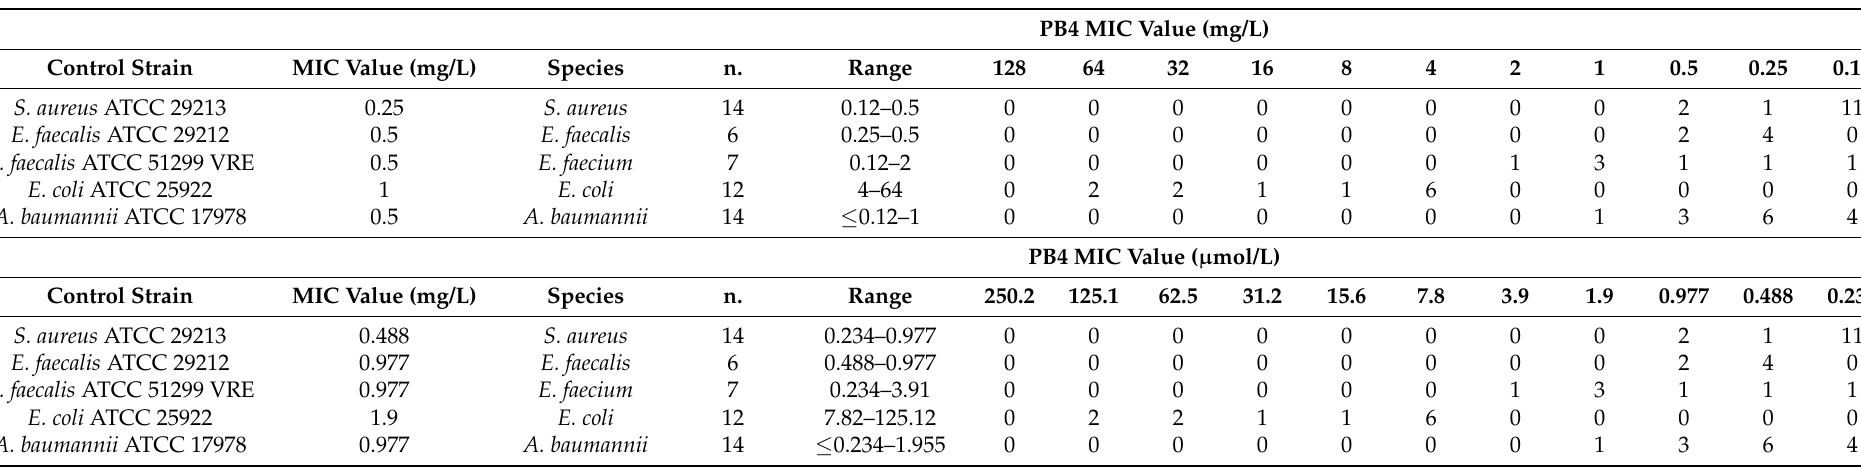
Table 5. The table reports the MIC values of PB4 on the control strains used as references. The number of clinical strains tested for each species, the PB4 MIC ranges obtained and the distribution of the results are shown